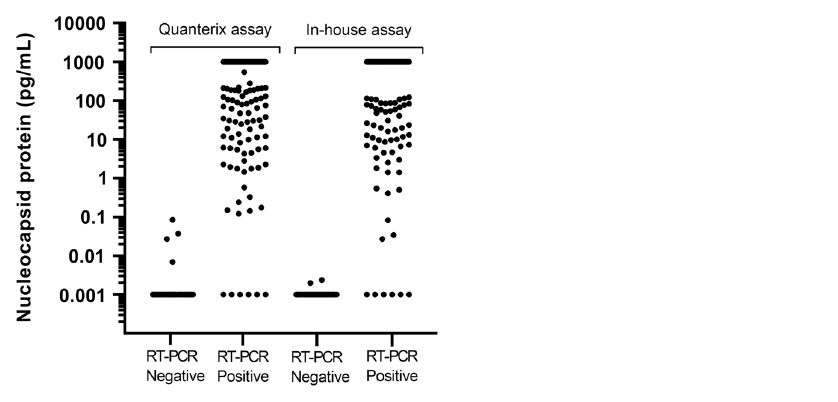
Figure 3. SARS-CoV-2 concentrations in real time RT-PCR negative and real time RT-PCR positive swab samples analyzed in the Quanterix assay and the in-house